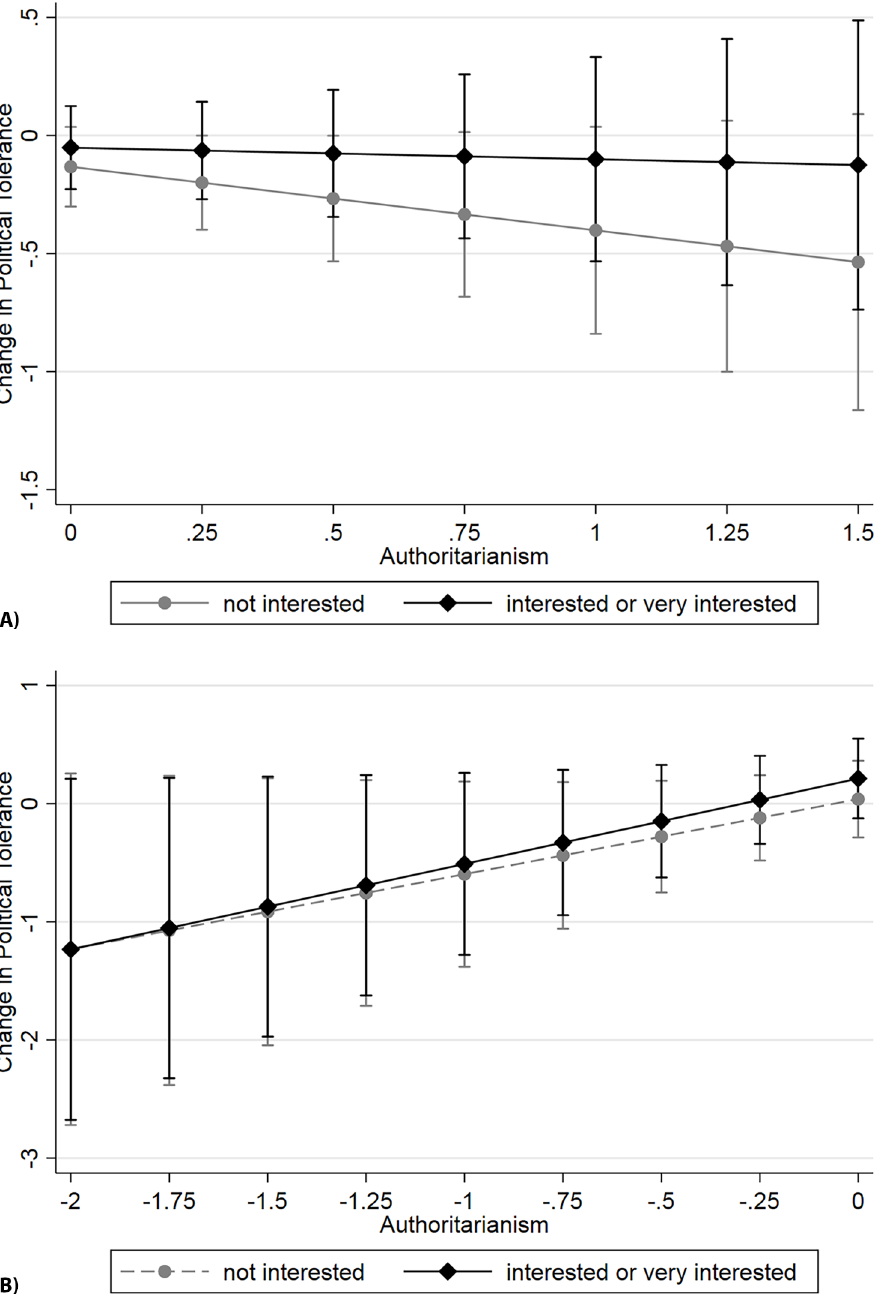
Figure 5. Conditional marginal effect in the forced exposure group: Risk message. Panel A: Low DTA authoritarians. Panel B: High DTA